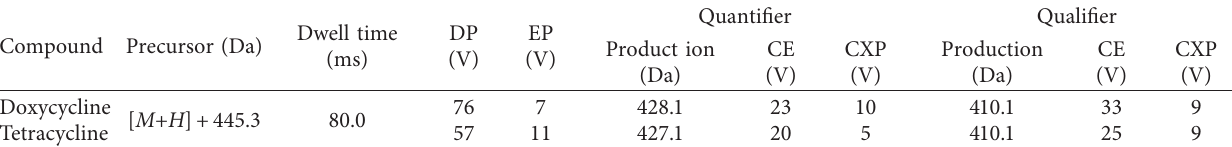
Table 1: Detection parameters of doxycycline and